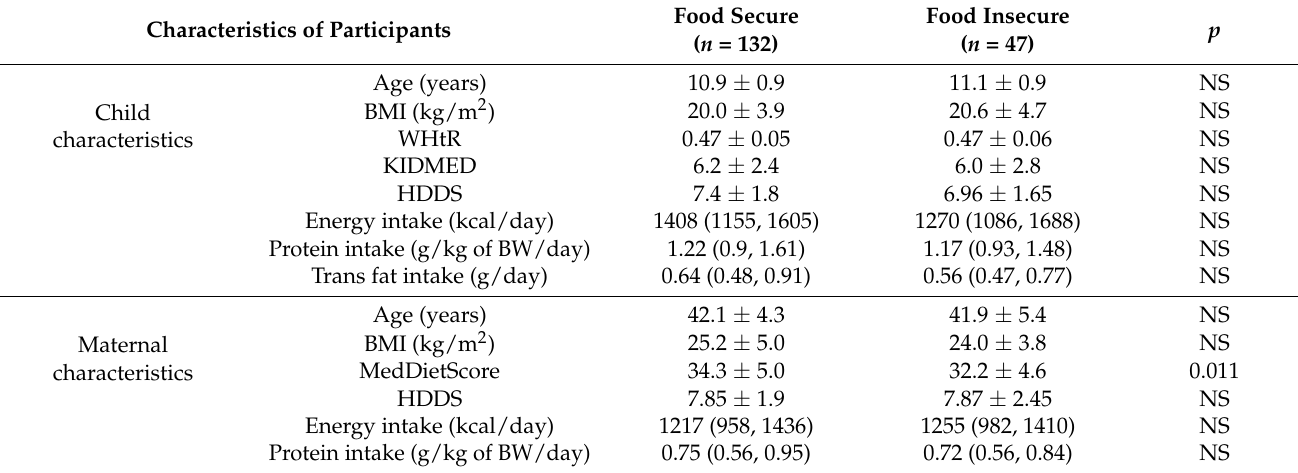
Table 5. Differences in maternal and child characteristics between food-secure and -insecure house- holds (means ± SD, or medians and their respective